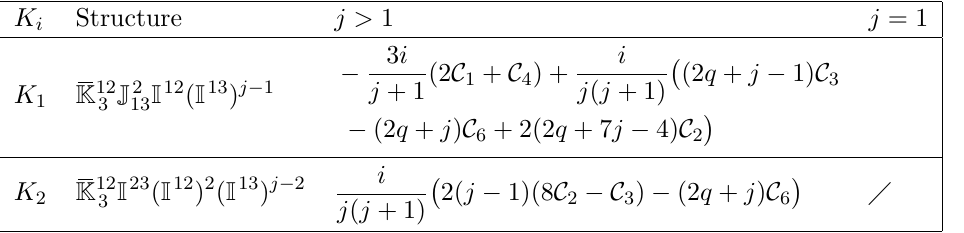
( QO ) T ( QO ) when QO h i